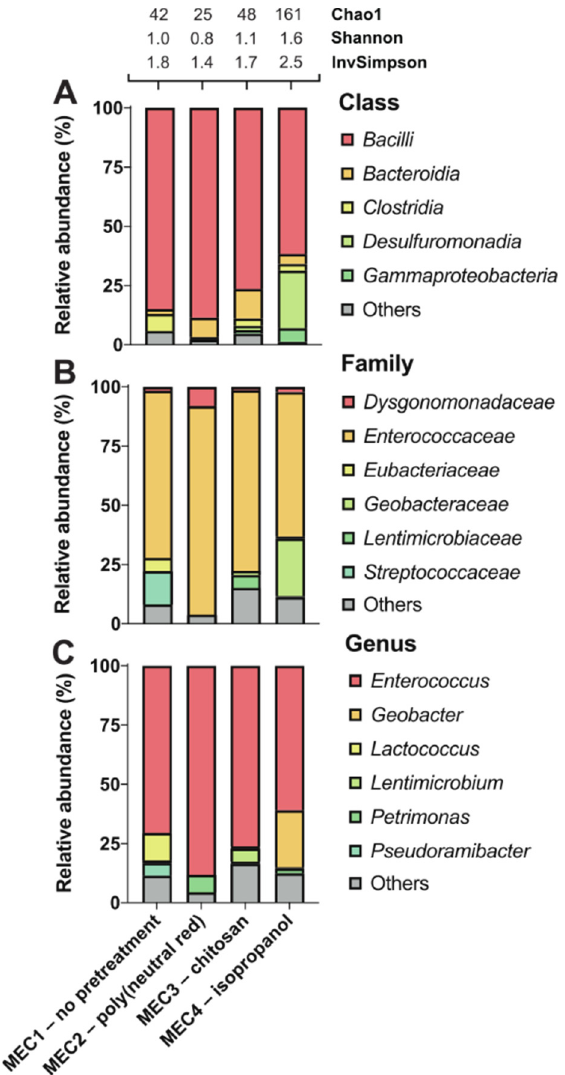
Figure 2. Effect of different electrode pretreatments on the enriched microbial communities of anode biofilm in MECs. Poly(neutral red) (MEC2), chitosan (MEC3), and isopropanol (MEC4) were used for the carbon felt electrode pretreatments, but the control electrode (MEC1) was not pretreated. Taxonomic profiles were set at the class ( A ), family ( B ), and genus ( C ) levels. Only representatives with a relative abundance >5% in at least one condition are shown. Detailed data are shown in Supplementary Table S3. Alpha diversity was estimated using the following indices: Chao1, Shannon, and Inverse Simpson.